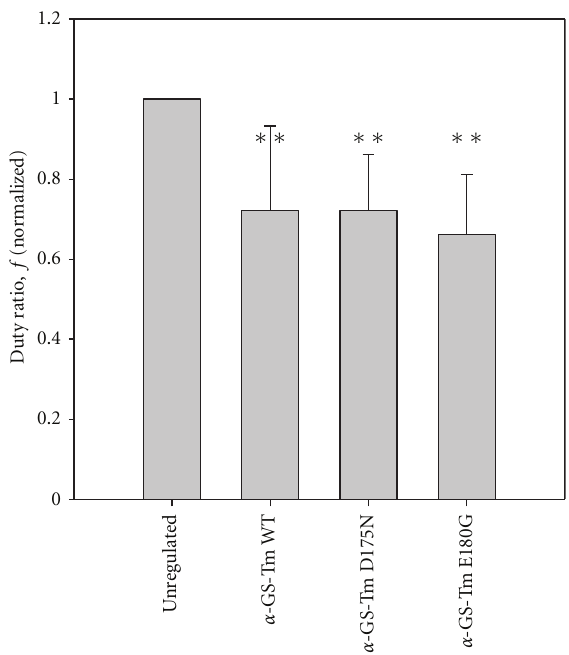
Figure 6: Cross-bridge duty ratio ( f ) during unloaded sliding of regulated thin filaments reconstituted with HcTn and either α -GS- Tm WT, α -GS-Tm D175N, or α -GS-Tm E180G is lower than for unregulated F-actin. Duty ratio was estimated using the method of Uyeda et al. [61] by varying HMM density ( ρ ) as described in Materials and Methods (see Section 2.8). Estimates of f were obtained by applying the band model and were normalized to the value obtained for WT at the same ρ . Bars indicate average normalized f for all ρ ( n = 5 − 8); error bars indicate S.D. Duty ratios for all three types of regulated thin filaments were significantly lower than for unregulated F-actin ( ∗∗ P < 0 . 01) but were not statistically di ff erent from each other ( P > 0 .